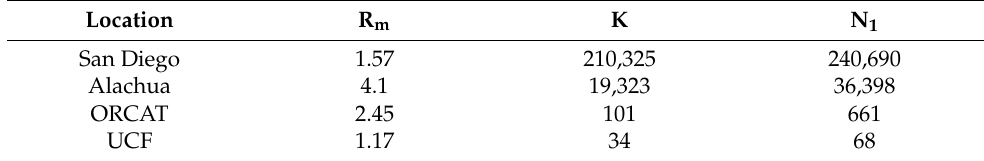
Table 2. Values used for Ricker model simulations. Data for San Diego and Alachua counties are from Foley et al. [22]; values for ORCAT and UCF are from the present